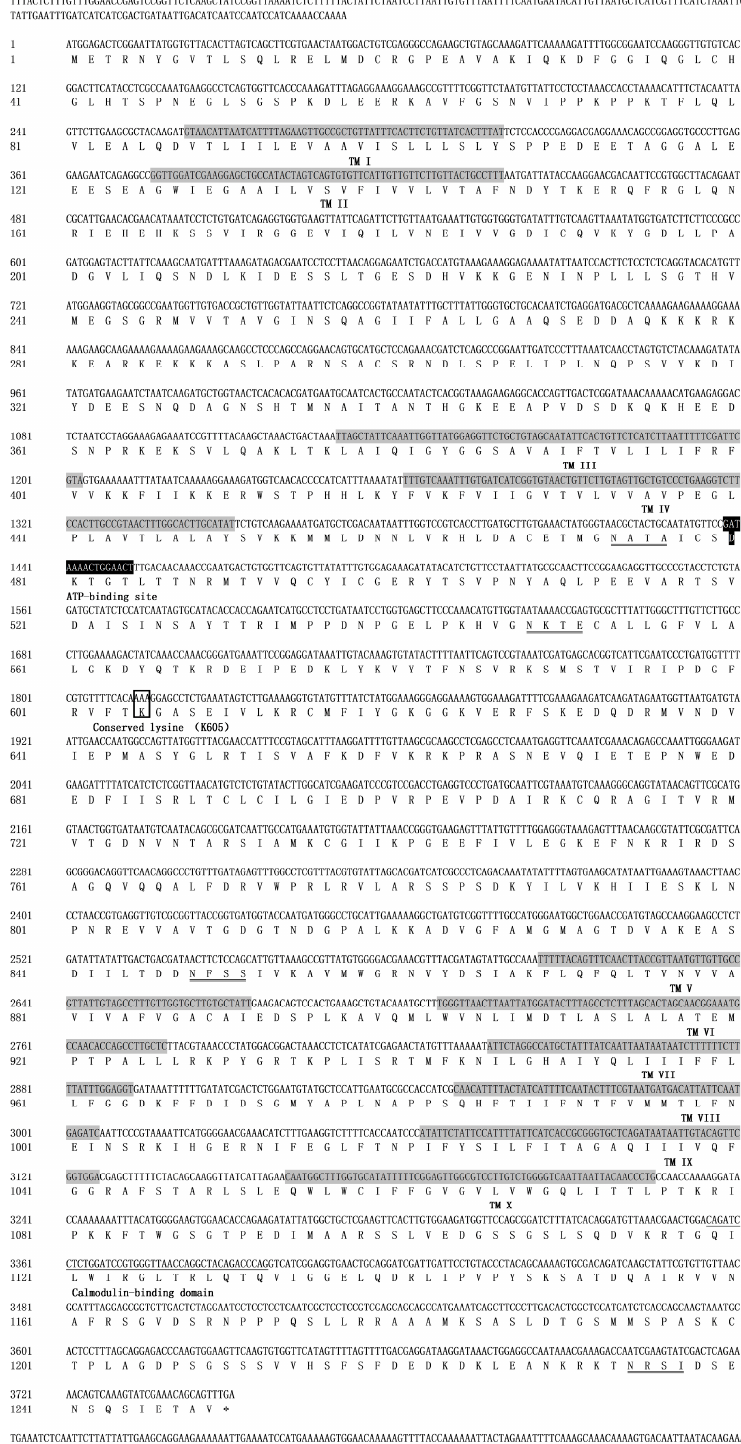
Figure 1. Nucleotide and deduced amino acid sequences of Ca 2+ -ATPase 1 gene ( TcPMCA1 ) from the carmine spider mite ( Tetranychus cinnabarinus (Boisduval)). Nucleotide numbers are provided on the left. The 10 transmembrane (TM) domains, which are denoted as TM I to TM X, are shaded. The ATP (Adenosine Triphosphate)-binding site, together with phosphorylable aspartate (D480), is shaded black, whereas the conserved lysine (K605) is boxed. The calmodulin-binding domain is indicated by a single line and the four N -glycosylation sites are indicated by double lines. * represents the termination signal.